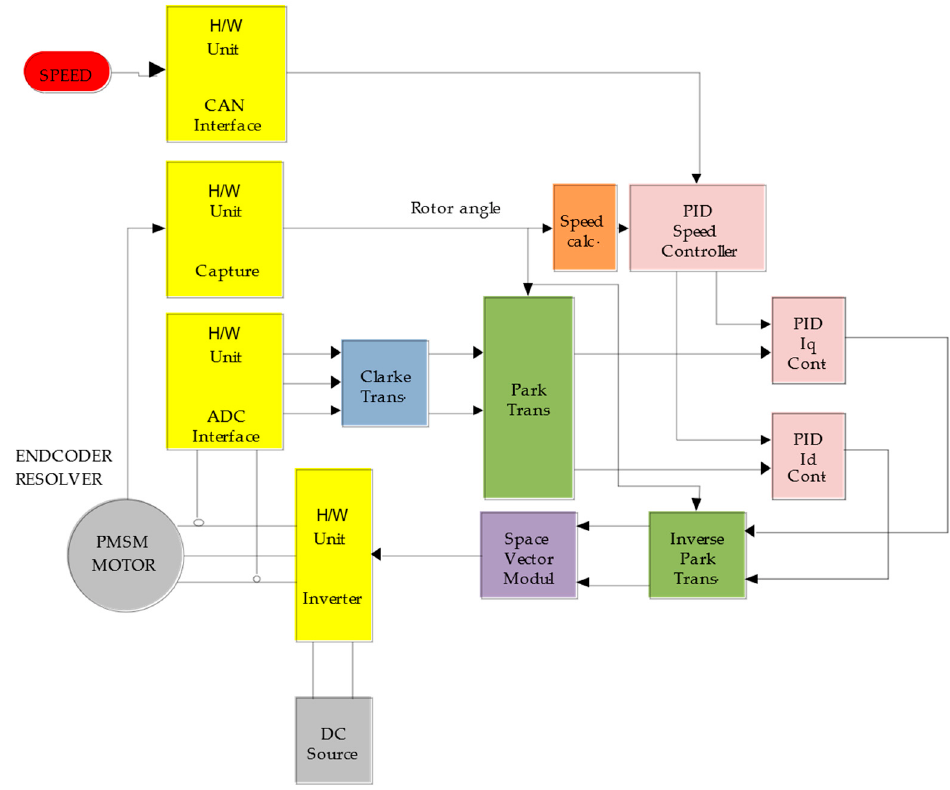
Figure 4. Block diagram of FOC algorithm.